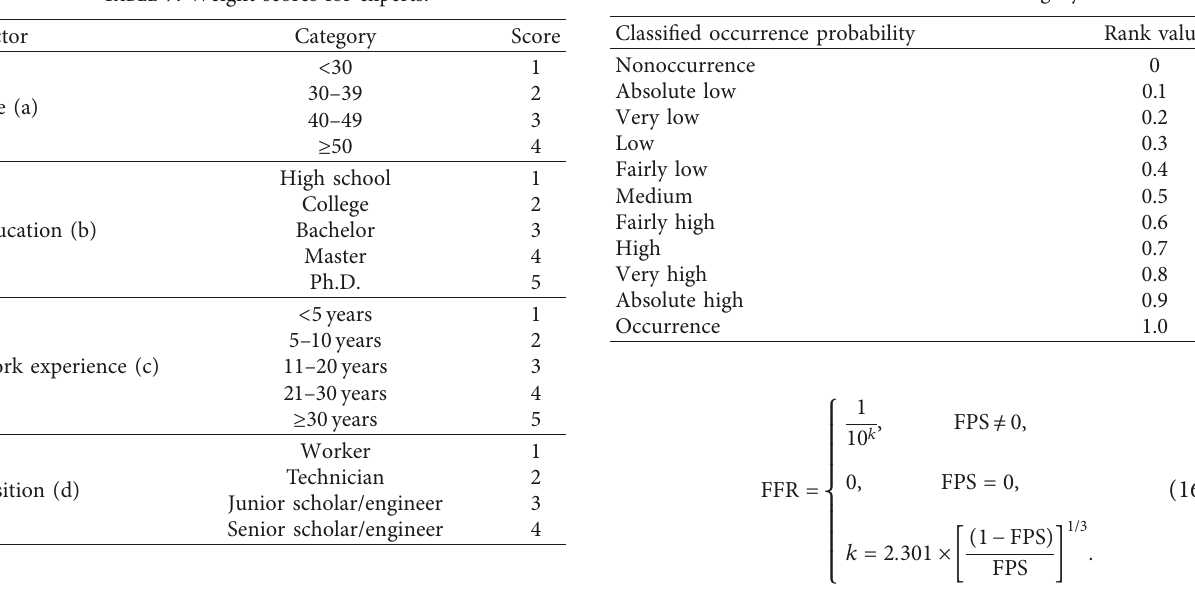
Table 7: Weight scores for experts. Table 8: Rank value of each